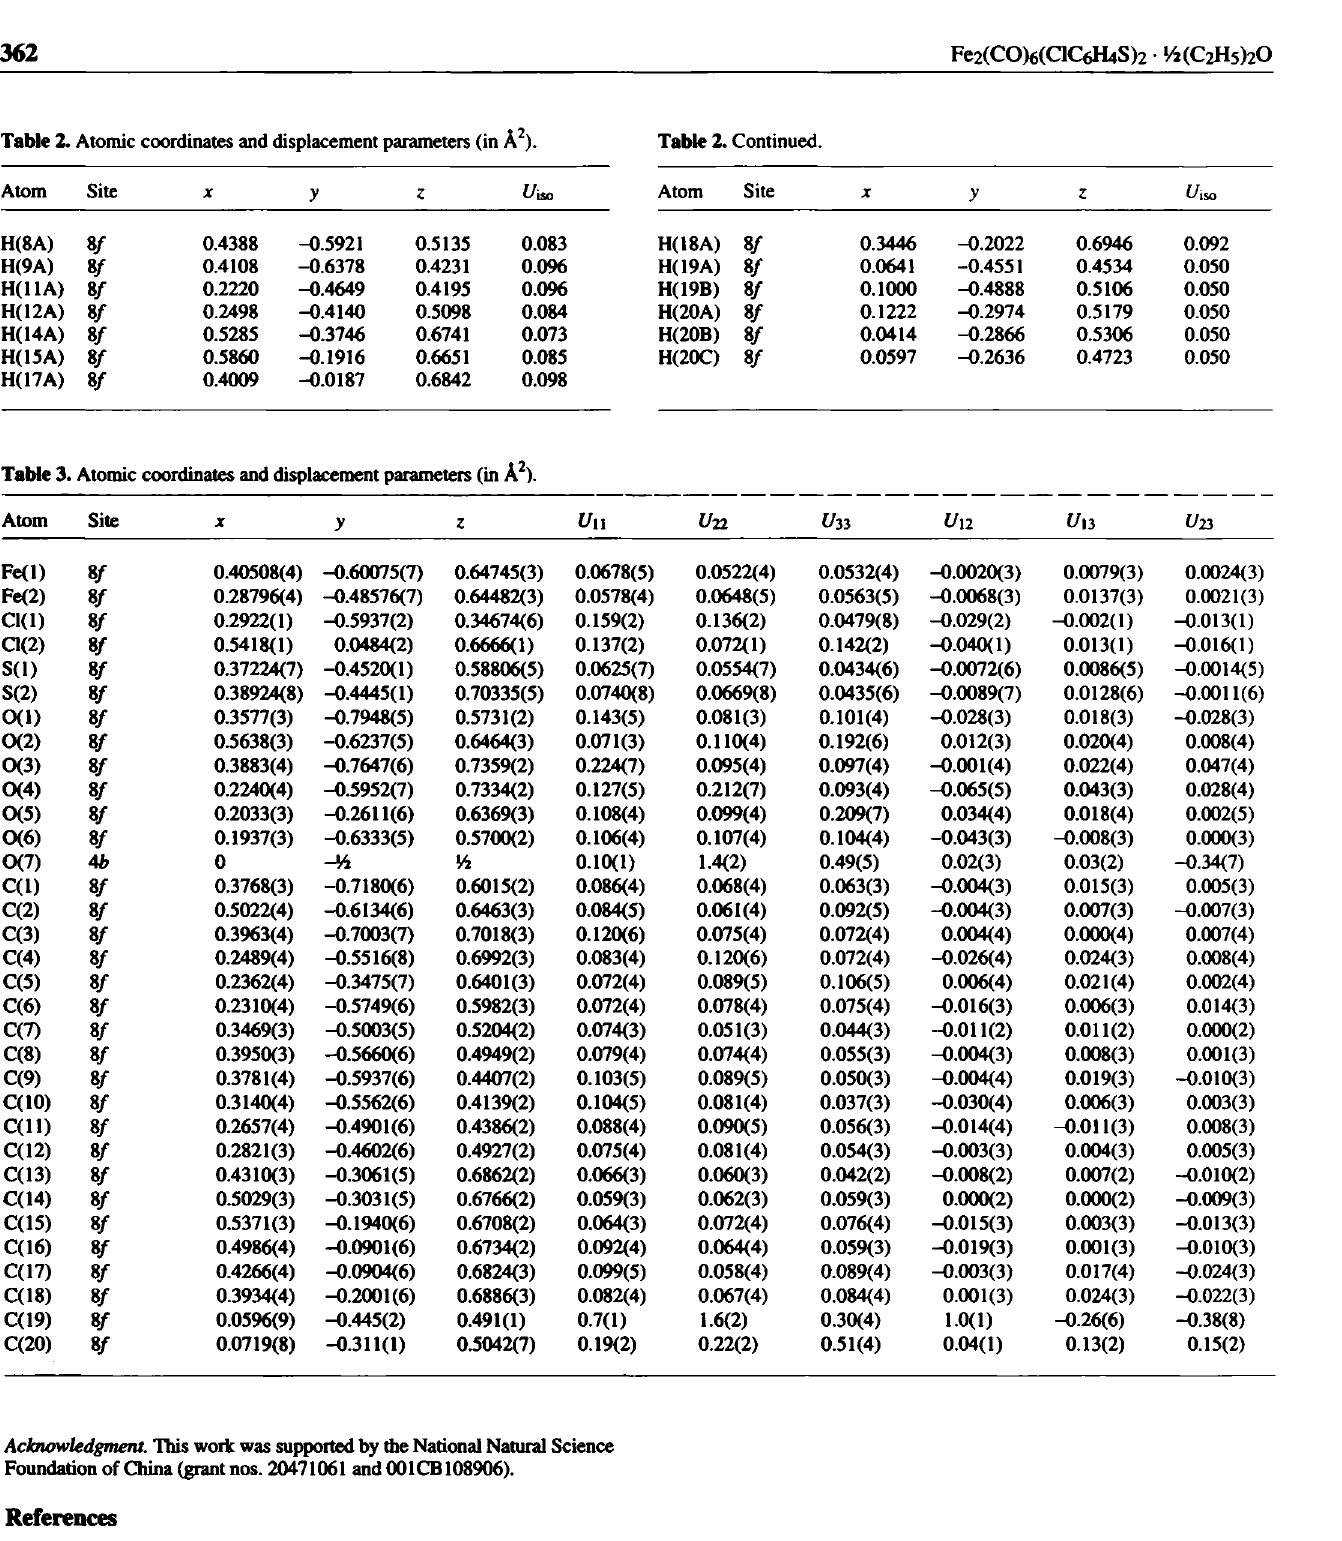
Table 2. Atomic coordinates and displacement parameters (in A 2 ).